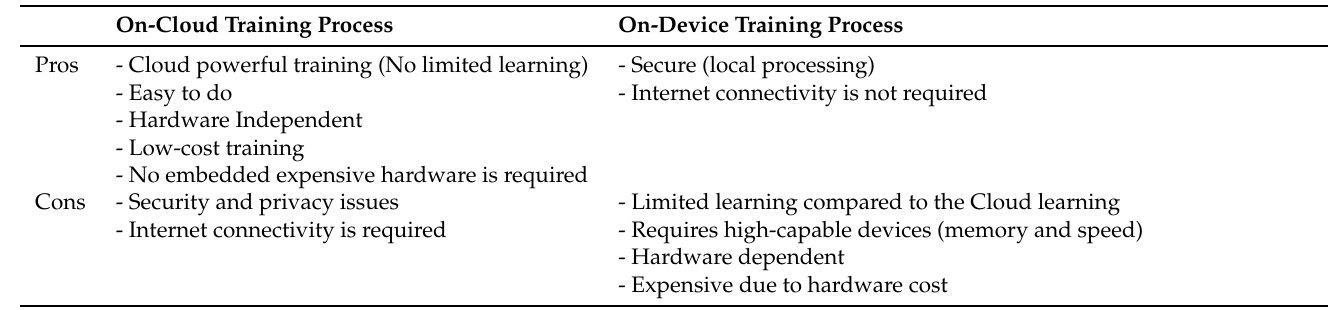
Table 4. The pros and cons of the On-Cloud training process and the On-Device training process.